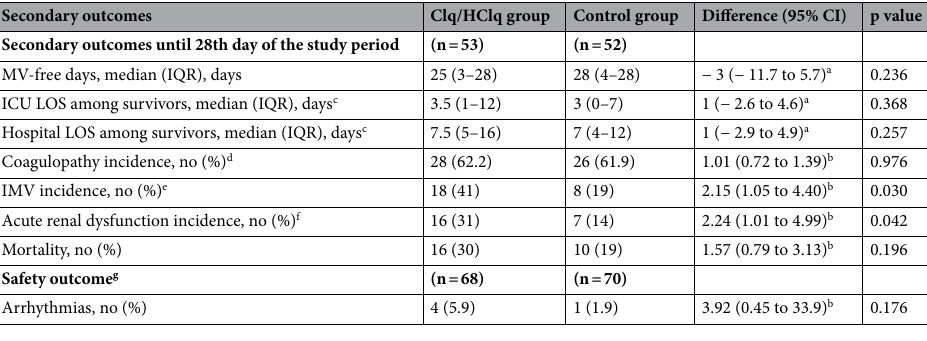
Table 2. Other secondary and safety outcomes. KDIGO Kidney Disease: Improving Global Outcomes; IMV invasive mechanical ventilation; ICU intensive care unit; LOS length of stay; HFNC high-flow nasal cannula; NIPPV noninvasive positive-pressure ventilation; IQR interquartile range; Clq chloroquine; HClq hydroxychloroquine; CI confidence interval. a Median difference with corresponding 95% CI calculated as an asymmetric Laplace distribution. b Risk ratios (RRs) with CIs calculated using the Wald likelihood test. c Considering the 38 survivors from the Clq/HClq group and 42 from the control group of the modified intention to treat (mITT) population. d Considering 45 from the Clq/HClq group and 43 from the control group of the mITT population who had no coagulopathy at baseline. e Considering the 44 patients from the Clq/HClq group and 42 from the control group of the mITT population who were not on MV at baseline. f Considering the 52 patients from the Clq/HClq group and 51 from the control group of the mITT population who were not at KDIGO stage 3 at baseline. g Safety population consisted of 137 patients, of whom 67 were in the Clq/HClq group and 70 were in the control